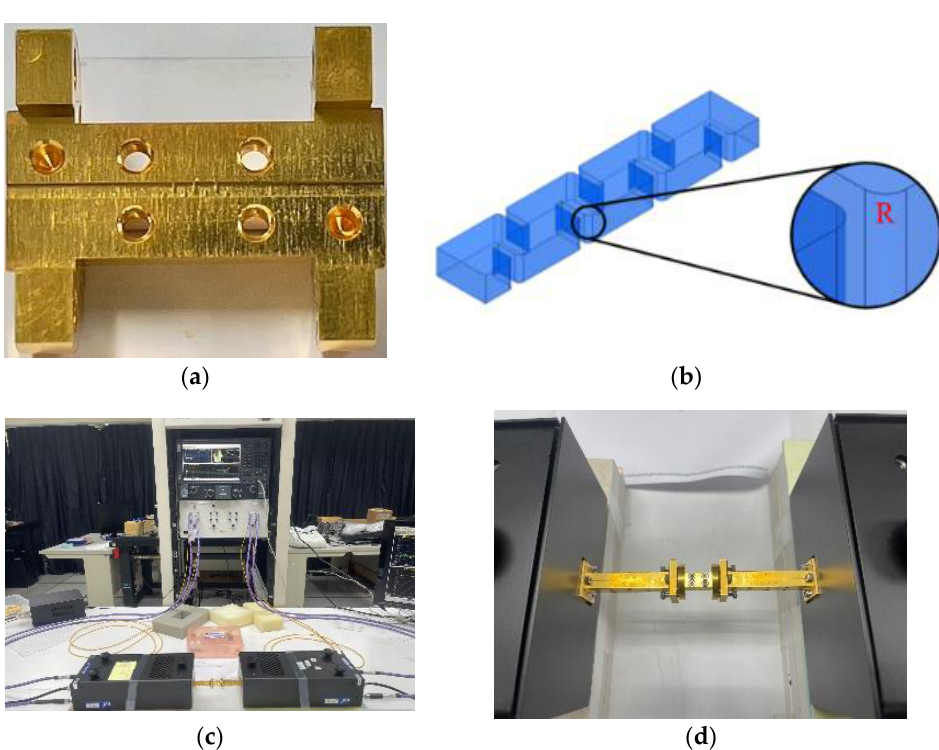
Figure 6. The simulation and measurement results of the proposed waveguide bandpass filter and the measured response of a straight waveguide for comparison.